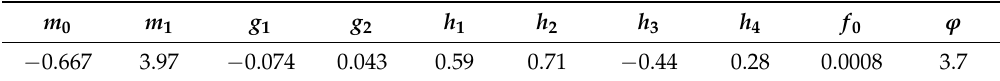
Table 1. The VmV model constants for AA5083.